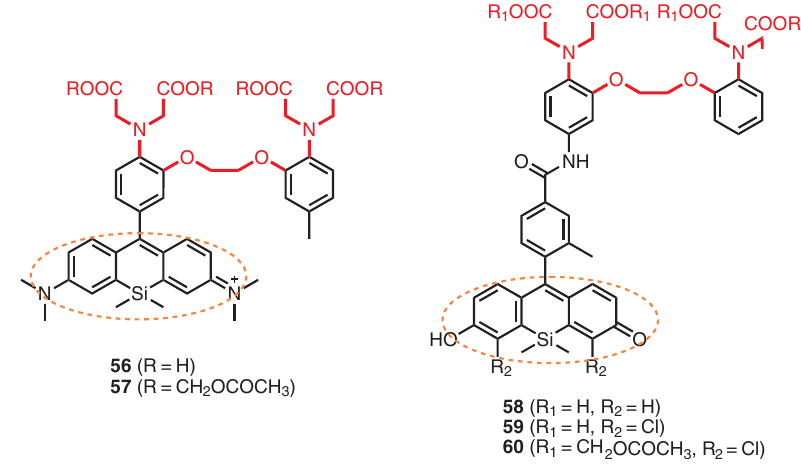
Figure 37: The structure of probe 56–60